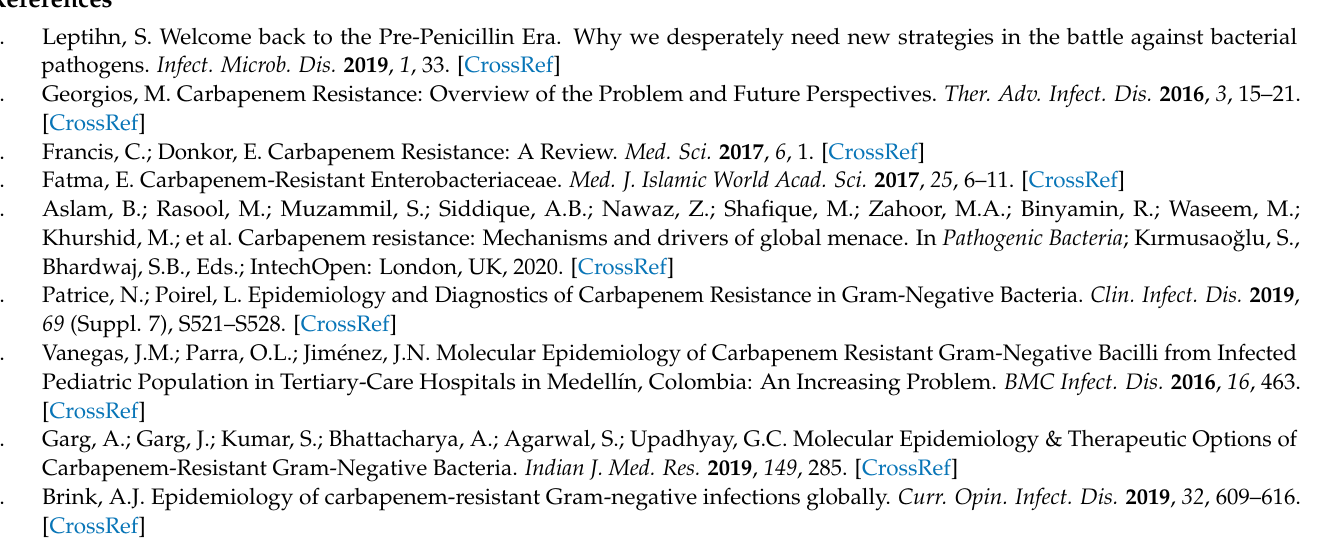
spp. (EB) based on ERIC-PCR; Figure S2: Dendrogram of Shigella spp. based on ERIC-PCR. Ssp1— Shigella spp.; SS— Shigella sonnei ; SF— Shigella flexneri ; Figure S3: Dendrogram of Klebsiella pneumoniae (KP) based on ERIC-PCR; Figure S4: Dendrogram of E. coli (EC) based on ERIC-PCR; Figure S5: Dendrogram of Acinetobacter spp. based on ERIC-PCR; Figure S6: Dendrogram of Pseudomonas aeruginosa (PA) based on ERIC-PCR; Figure S7: Dendrogram of Serratia marcescens (SM) based on